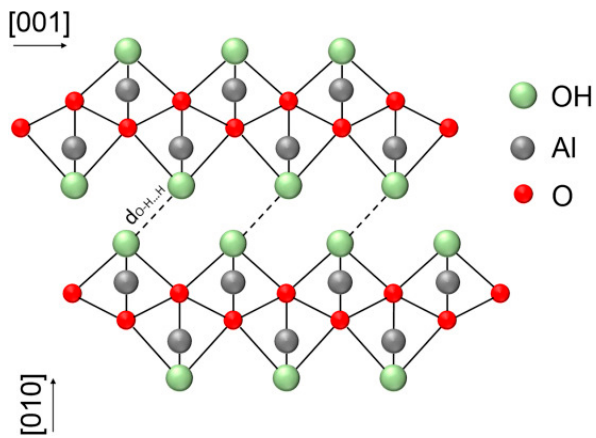
Figure 4. Molecular structure of Boehmite. Reprinted with permission from [26]. Copyright 2017 John Wiley & Sons.